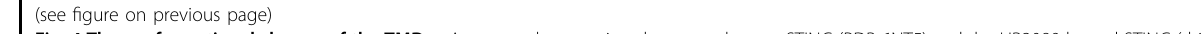
Fig. 4 The conformational change of the TMD. a A structural comparison between the apo STING (PDB 6NT5) and the HB3089-bound STING (this study). The two STING forms are colored as in Fig. 2d. The TMD is indicated by the green box. The N-terminal loop and the TM1 are highlighted. b A top view of the boxed region in a . Each helix of the TMD rotated anticlockwise with somewhat different extents as indicated by the curved arrows. The TM1 and the TM4 also moved toward the two-fold axis (oval). The side ( c ) and top ( d ) views of the boxed view in a , showing that the TM1 revolved on its own axis as compared that of the apo STING. Obviously, the residue Leu26 on the TM1 from one monomer has to cross the Ala129 on TM4 from the other monomer during the process of revolution. For clarify, only the TM1 and TM4 are shown. e – i The effects of the STING residue A129 mutations on HB3089/diABZI (compound3)/MSA-2-induced expression of the ISG reporter. j The effects of the STING residue A129L mutation on SAVI-related mutations-induced expression of the ISG reporter. Data are presented as the means ± SD of triplicate experiments, signi fi cance is determined with One-Way ANOVA test; ns, not signi fi cant, * P < 0.05, ** P < 0.01, ** * P < 0.001, **** P <